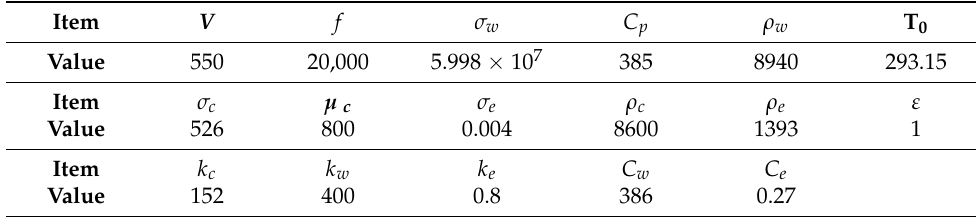
Table 4. Finite element simulation parameters.